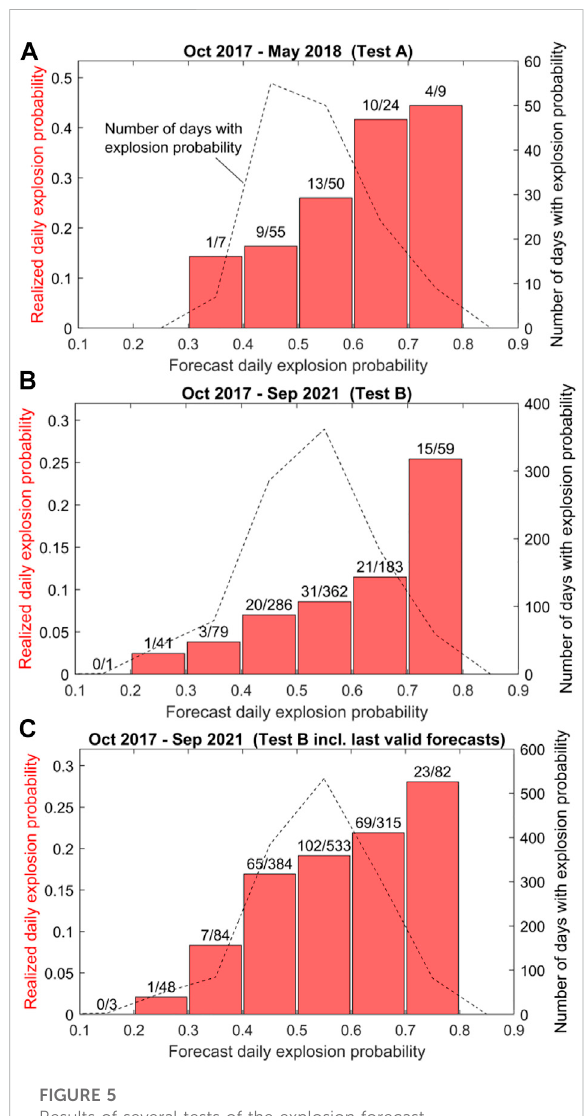
FIGURE 5 Results of several tests of the explosion